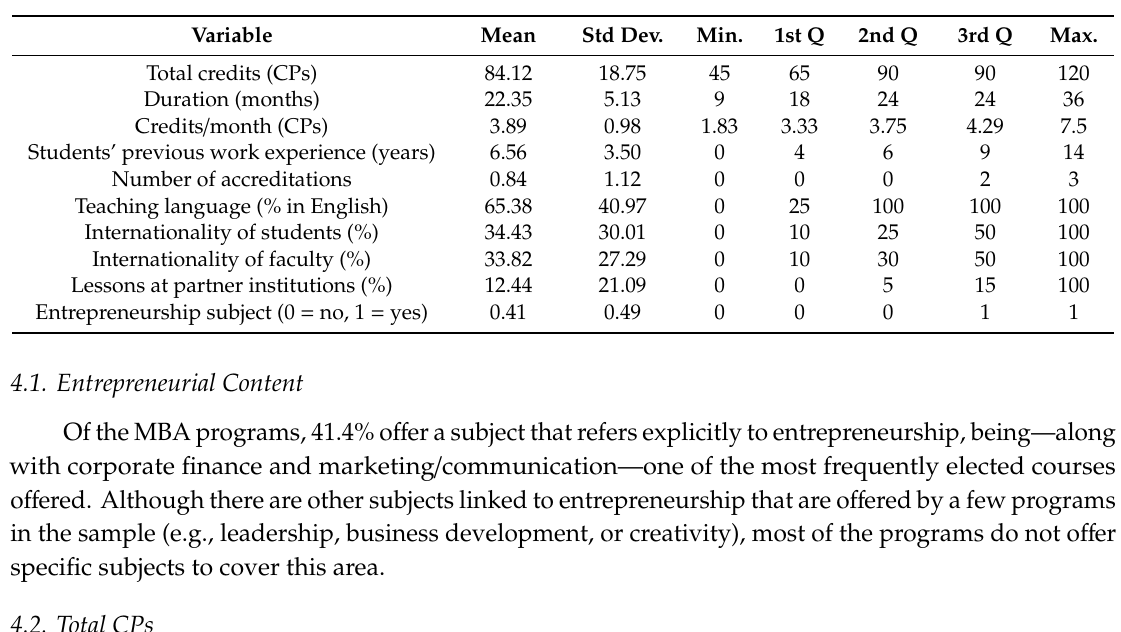
Table 1. Quantitative characteristics in the European part-time MBA